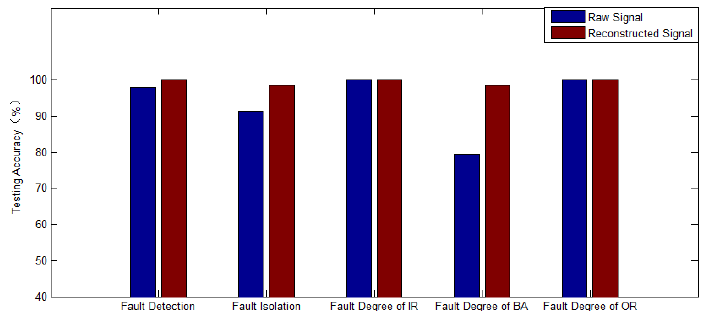
Figure 19. Comparison of fault diagnosis effect of rolling bearings based on decision fusion.